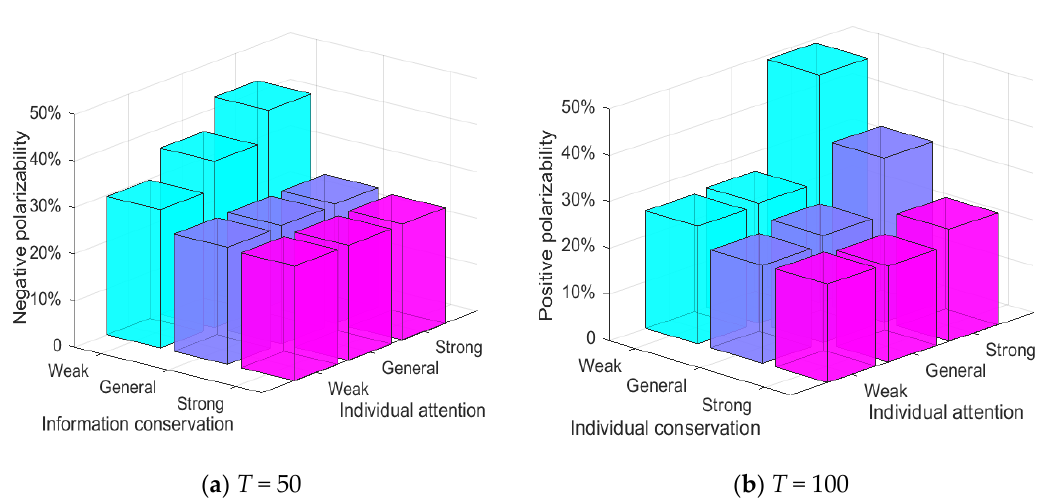
Figure 22. Relationship between conservation, individual attention and attitude polarization. ( a ) T = 50; ( b ) T = 100.